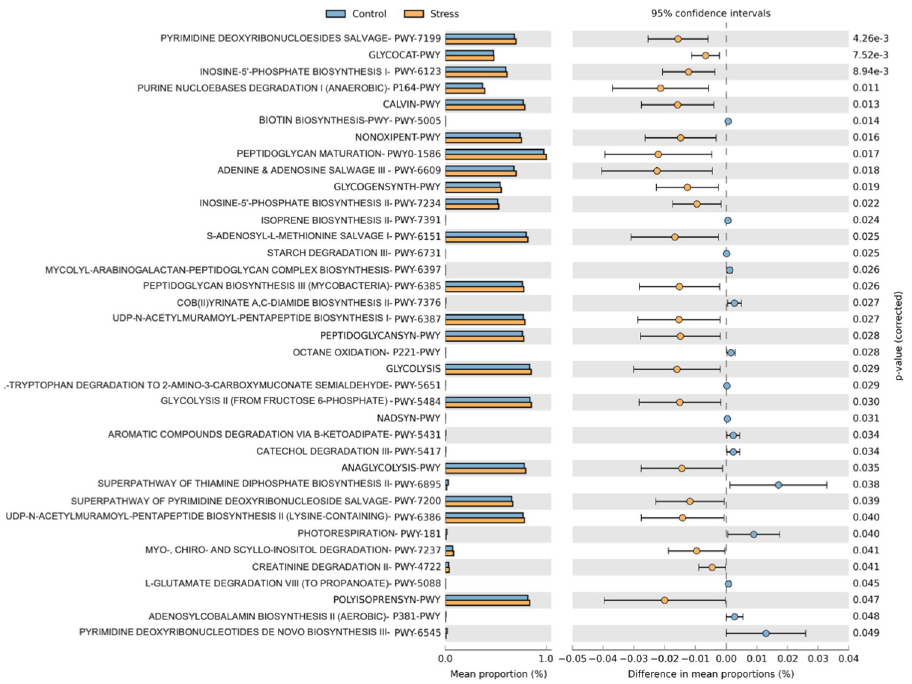
Fig 5. Prediction of metagenome function using PICRUSt2. Thirty-seven different pathways were predicted to alter in the oral microbiota due to psychological stress ( � p < 0.05; Welch’s t-tests). Most of the metabolic pathways were upregulated in the stress group indicating high metabolic activity under stress